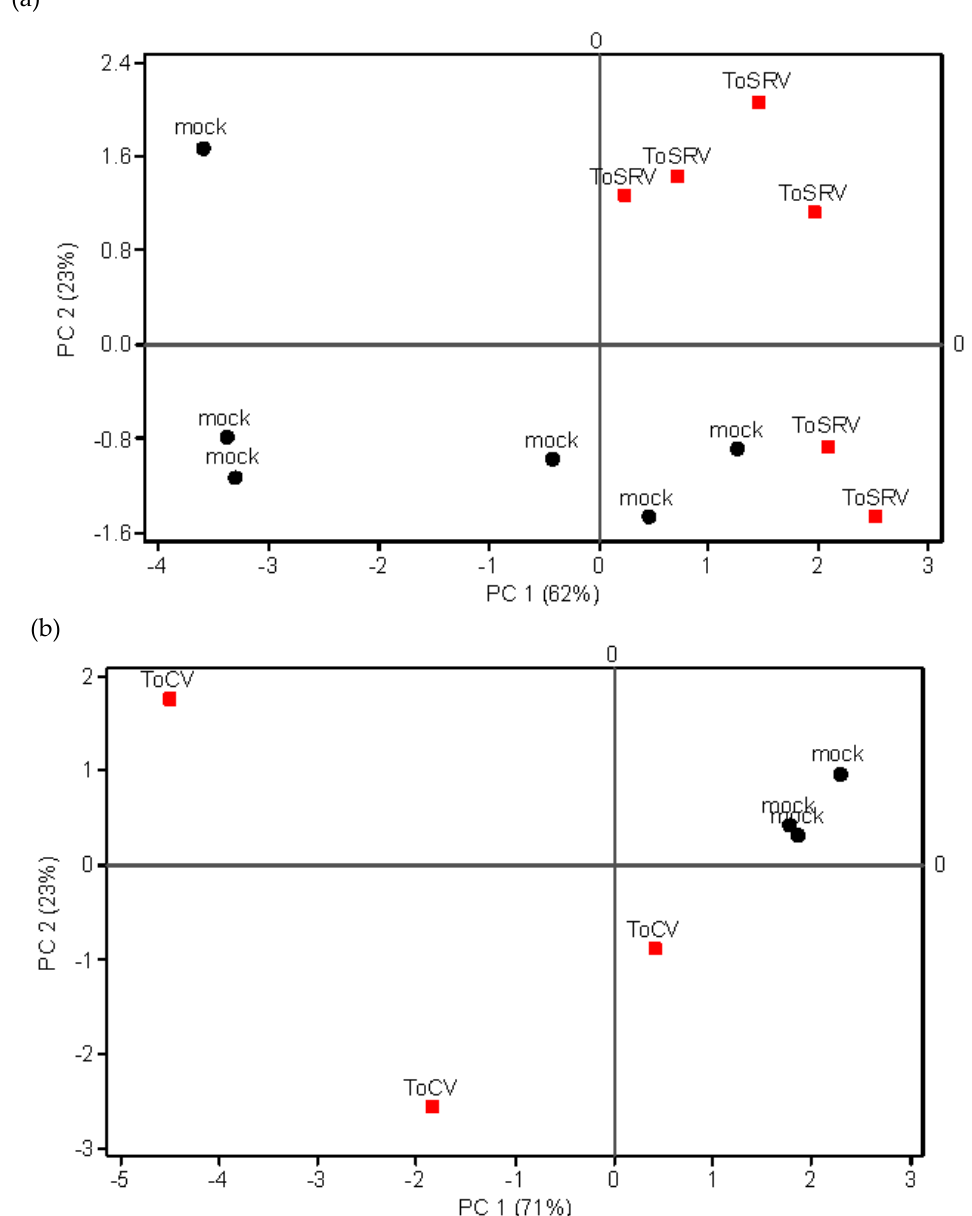
Figure 2. Loading plots for principal component analysis (PCA) with volatile compounds emitted by mock ‐ inoculated and virus ‐ infected plants. ( a ) mock ‐ inoculated and ToSRV volatile emissions; by mock-inoculated and virus-infected plants. ( a ) mock-inoculated and ToSRV volatile emissions; ( b ) mock ‐ inoculated and ToCV volatile emissions. ( b ) mock-inoculated and ToCV volatile